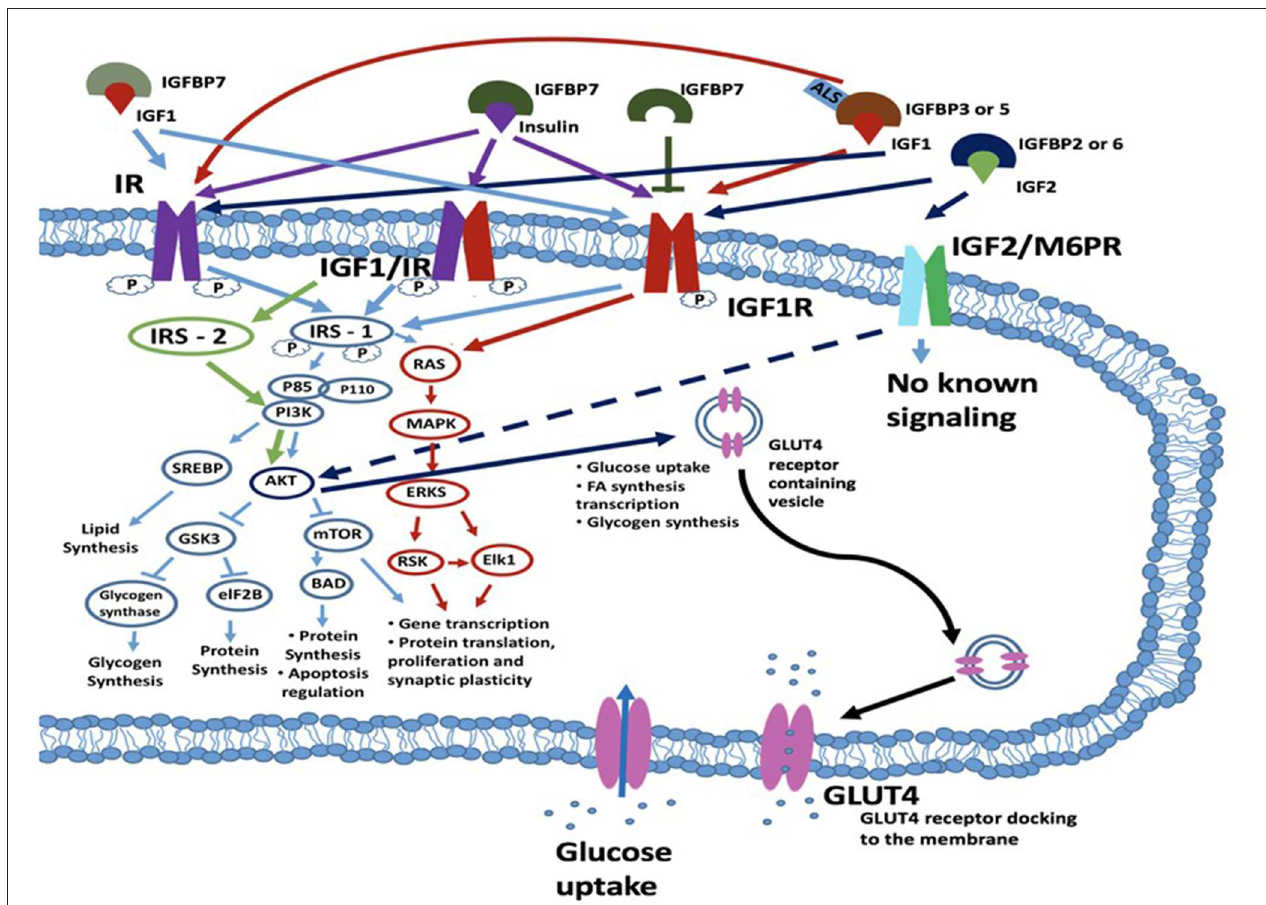
FIGURE 1 | Schematic diagram of a cell with insulin/IGF signaling cascades depicted. Insulin may exert its effects through one of three transmembrane kinase receptors: IR, IGF1R or the IGFR/IR hybrid receptor. The IGF2R/M6P receptor has an unknown signaling potential. IGF1 can act alone or complexed with IGFBP3 or IGFBP5 and ALS and interacts with IGF1R and IR. IGF2 when bound to IGFBP2 or IGFBP6 interacts with the IGF2R (M6PR), IR or IGF1R. Insulin signaling is also regulated by IGFBP7, which can bind both IGF1 and insulin and bind with their receptors. IGFBP7 can also bind to the IGF1R which leads to the blockade of the IRS1 intrinsic pathway. Following ligand-receptor interaction, signal transduction to the cytosol is via the kinase domains of the IR, IGF1/IR and IGF1R receptors. The main targets for phosphorylation are the IRSs, which further transduce the signals through divergent messenger cascades, eventually leading to the various metabolic effects of insulin and IGFs. These effects can be metabolic or mitogenic and include lipid synthesis via PI3K/SREBP pathway, glycogen synthesis and protein synthesis and apoptosis regulation via the PI3K/AKT/GSK3/eIF2B pathway; and transcription and translation, cellular proliferation and synaptic plasticity via the RAS/MAPK/ERKS/RSK/Elk1 pathway. For an excellent review and more detail, see ( 23). IGF2 binds to the IGF2R (also known as the M6P receptor) and lacks intrinsic kinase activity but has been reported to regulate AKT activity. AKT acts to regulate multiple downstream targets including GSK3 and MTOR but is also involved in glucose uptake and the expression of GLUT4 which is a key player in glucose uptake. ALS, acid-labile subunit glycoprotein; eIF2B, eukaryotic initiation factor 2B; GSK3 β , glycogen synthase kinase 3 beta; IGF1R, insulin growth factor receptor; IGFBP, insulin growth factor binding protein; IR, insulin receptor; IRS1,